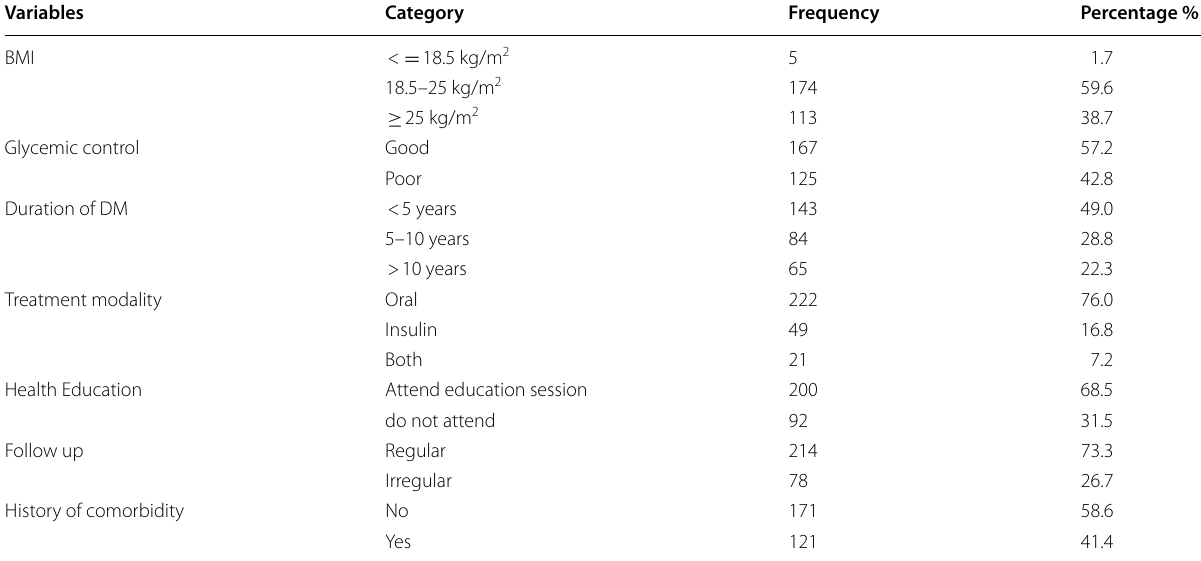
Table 4 Clinical characteristics of individuals with type 2 DM in Bahir dar, Ethiopia, 2021(292)